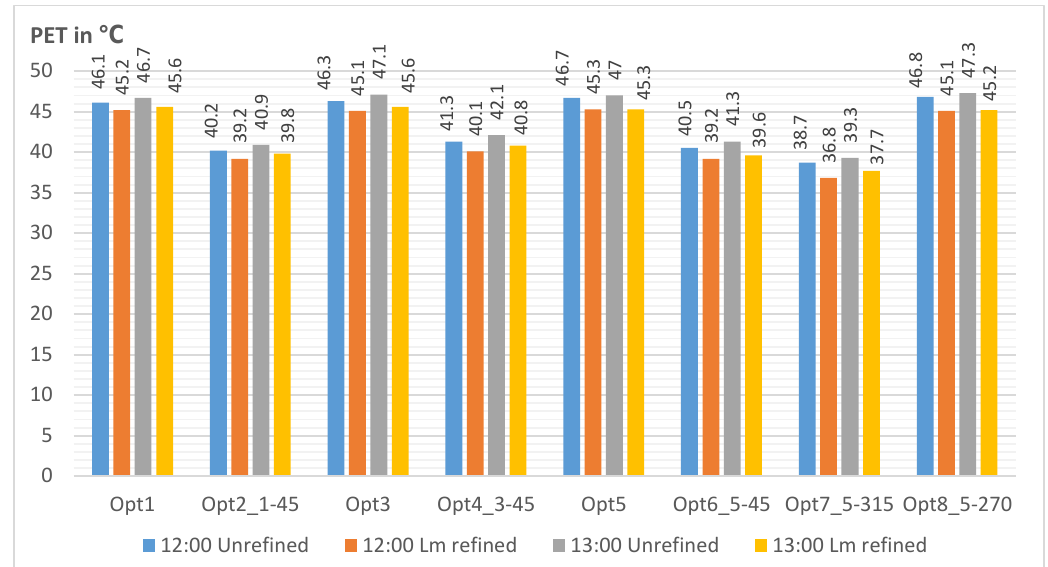
Figure 15. PET values for the eight Grasshopper generated urban forms before and after refining land use design variables for better greenery ( L m = 2.0729). Opt stands for optimization whereas the last value in the name of the primitive form stands for the degree of orientation.